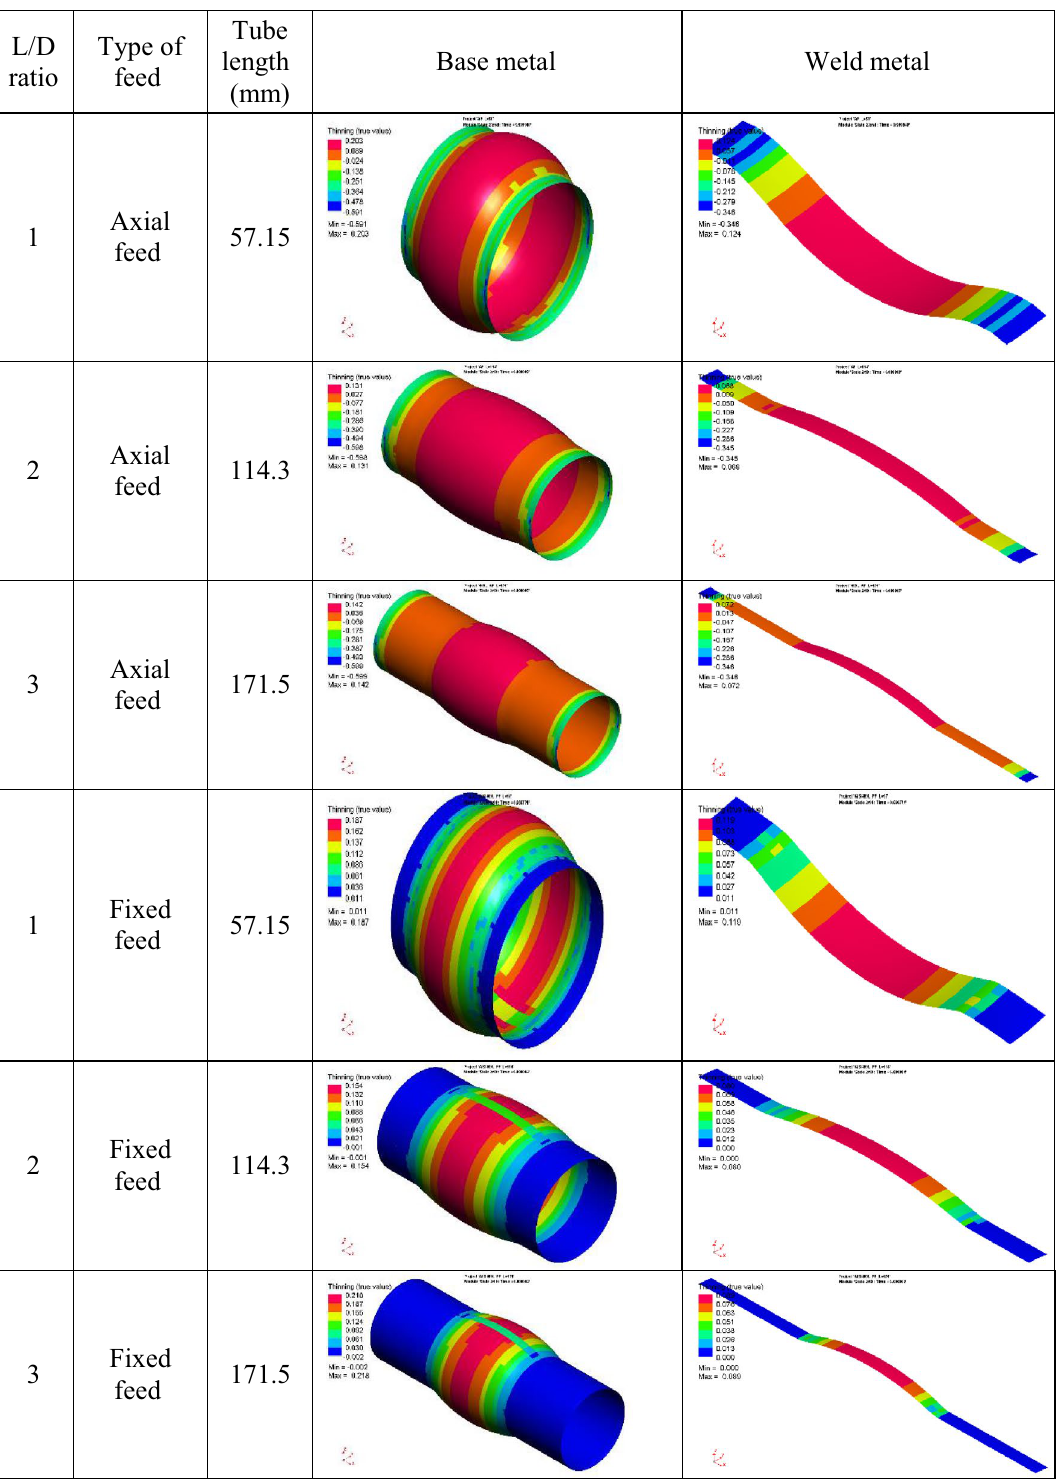
Table 6 FEA AISI409L grade material of bulging tubes for base and weld